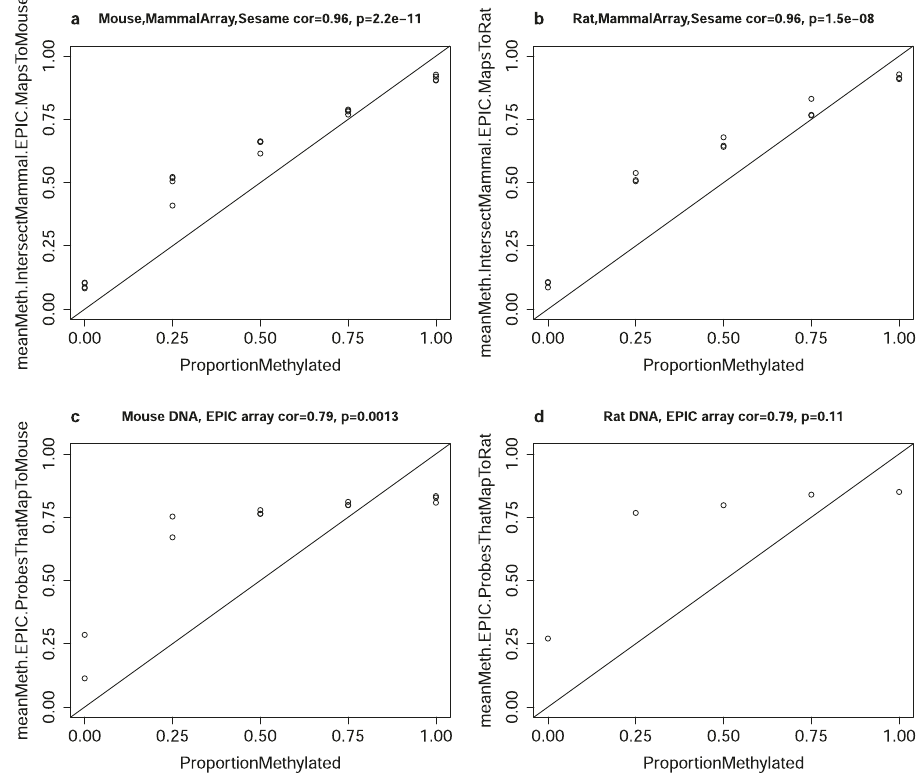
Fig. 5 Calibration data: mean methylation across probes shared between the human EPIC array and the mammalian array. The mammalian methylation array contained 5574 probes targeting the same CpG that can also be found on the human EPIC array that was not included based on being human biomarkers. However, the mammalian array probes were engineered differently than EPIC probes so that they would more likely work across mammals. By applying both array types to calibration data, we are able to compare the calibration of the overlapping probes in mice ( a , c ) and rats ( b , d ). Upper panels ( a , b ) and lower panels ( c , d ) present the results for the mammalian array and the EPIC array, respectively. The benchmark measure (ProportionMethylated, x axis) versus the mean methylation value ( y axis) across 4341 CpGs that map to mice ( a , c ) and 3948 CpGs that map to rats ( b , d ). The CpGs used to compute the mean (i) are present on the human EPIC array, (ii) present on the mammalian array, and (iii) apply to the respective species according to the mappability analysis genome coordinate fi le. Sample sizes: n = 20 arrays for mice ( a , c ) and n = 15 arrays for rats ( b , d ). The title reports the Pearson correlation coef fi cients and two-sided p-values calculated using a Student ’ s t